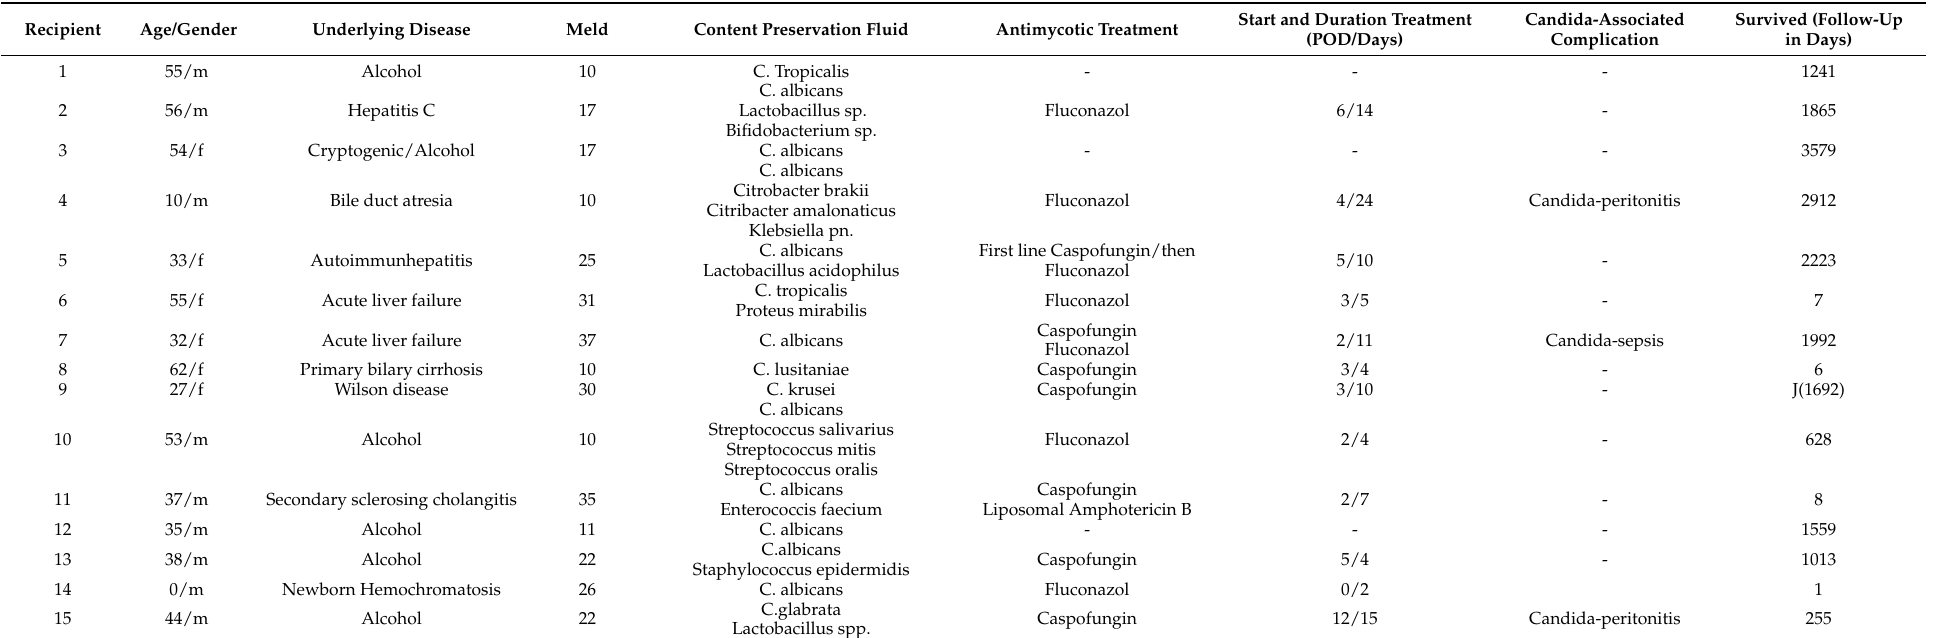
Table 1. Liver recipient data.